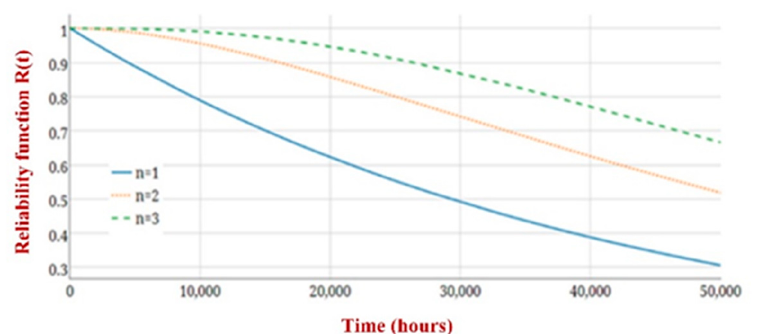
Figure 23. The in fl uence of series redundancy on FC dependability.